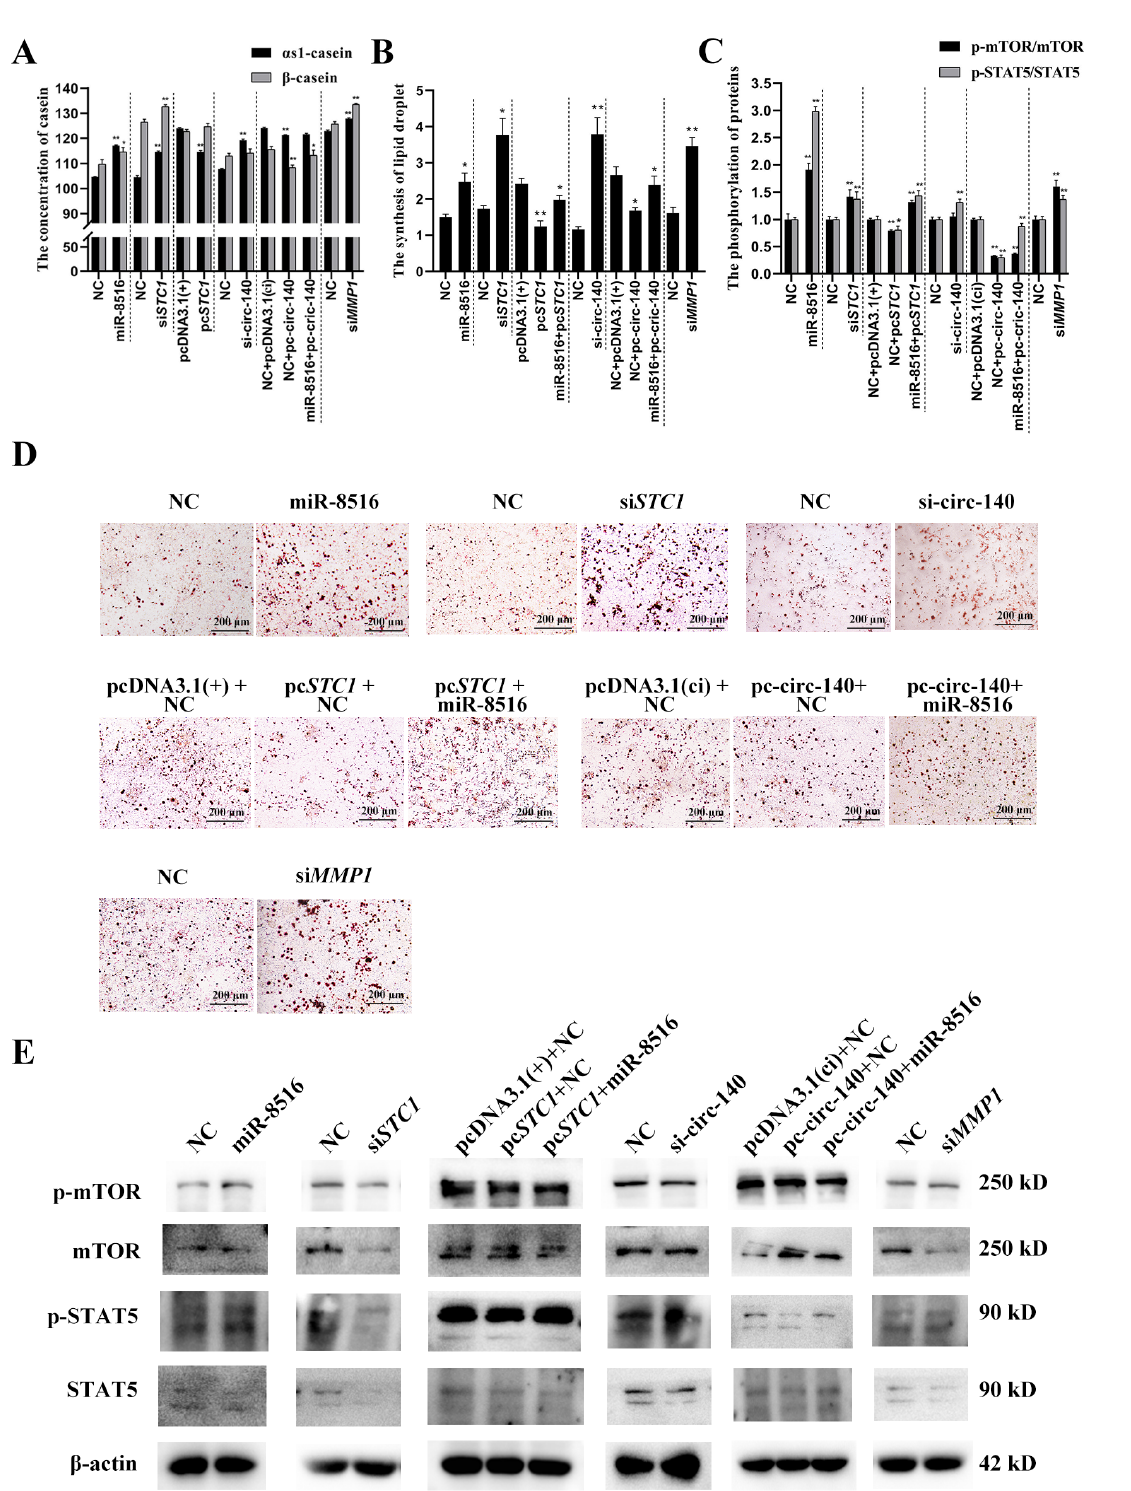
Figure 5. Effects of the circ-140/chi-miR-8516/ STC1 - MMP1 axis on α s1-/ β -casein secretion and lipid formation. ( A ) The regulation of α s1-/ β -casein secretion by the circ-140/chi-miR-8516/ STC1 - MMP1 axis; ( B , D ) the regulation of lipid formation by the circ-140/chi-miR-8516/ STC1 - MMP1 axis; ( C , E ) The phosphorylation of mTOR and STAT5 regulated by the circ- 140/chi-miR-8516/ STC1 - MMP1 axis. * p < 0.05; ** p <